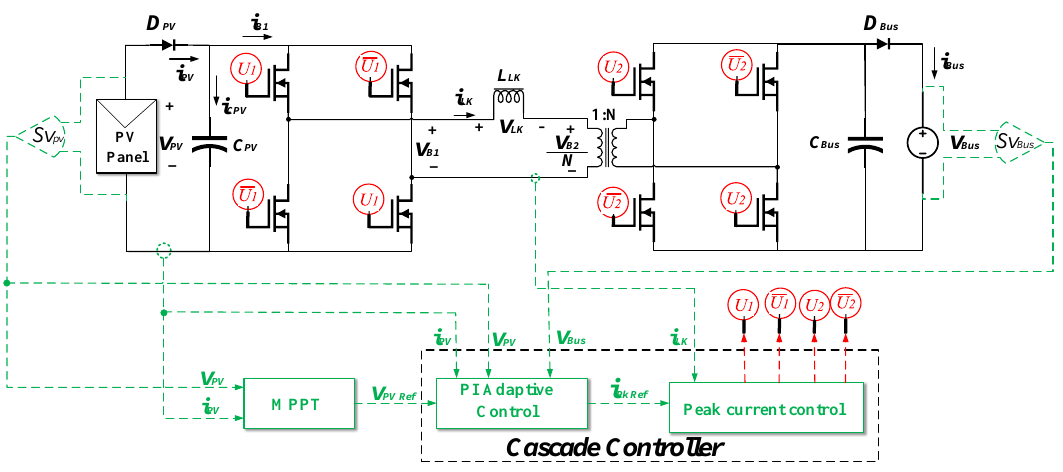
Figure 5. PV system proposed cascade